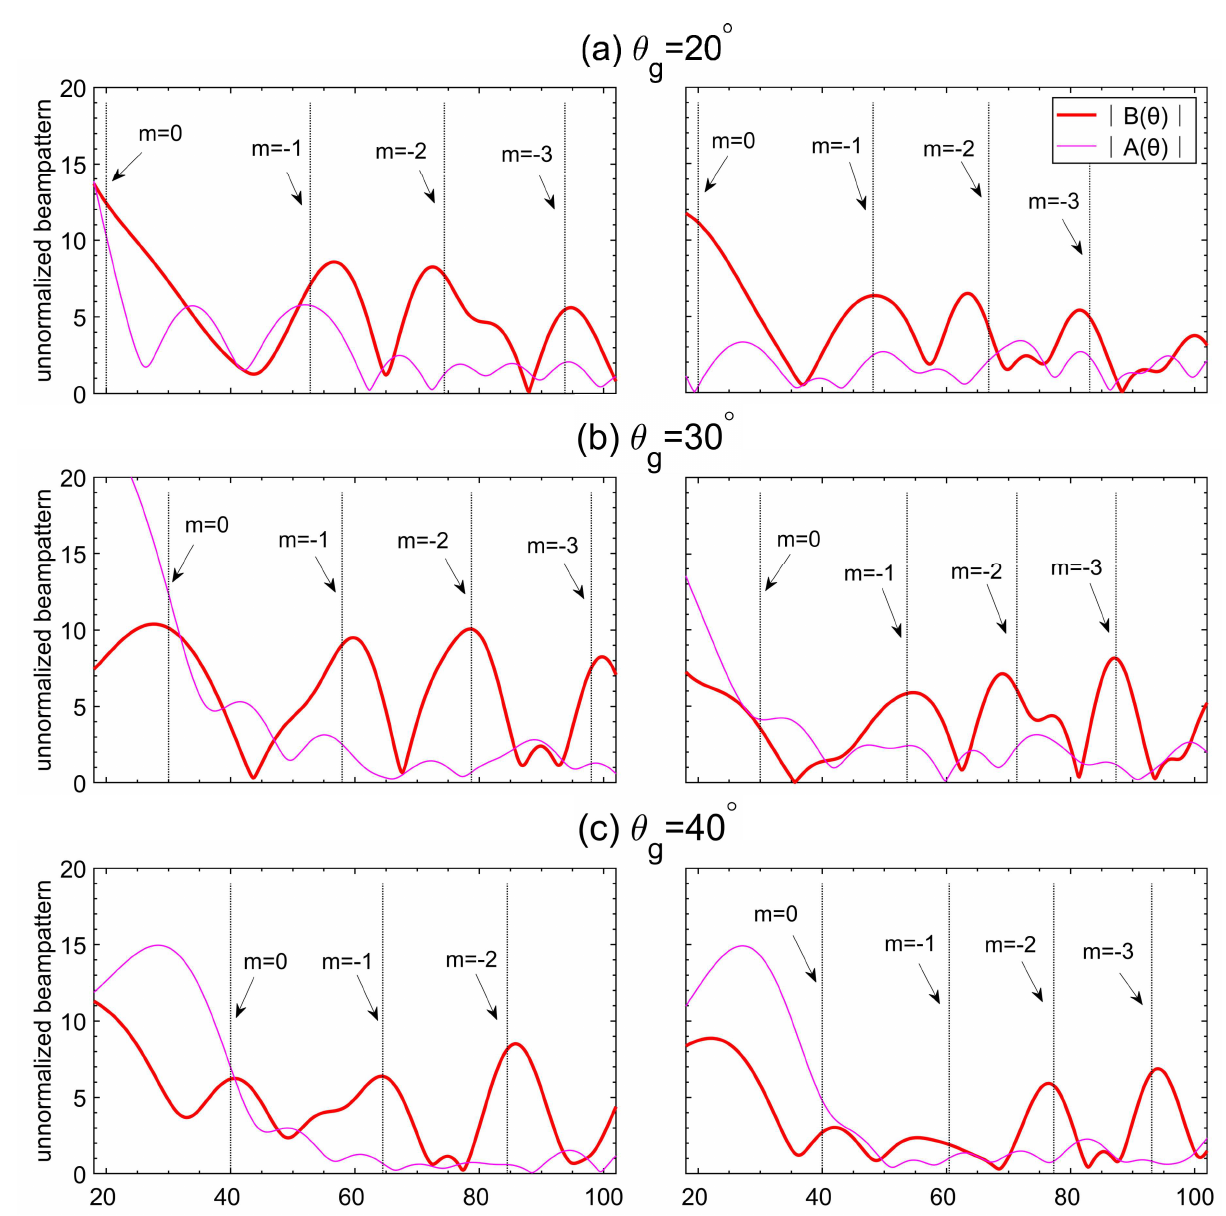
Figure 4. Beamforming output for three different incident grazing angles, θ g = 20 ◦ in ( a ), θ g = 30 ◦ in ( b ), and θ g = 40 ◦ in ( c ). The left column of figure is for frequency f = 22 kHz ( d < λ /2), whereas the right column is for f = 27 kHz ( d > λ /2). The dotted lines represent the scattered grazing angles predicted by the Bragg